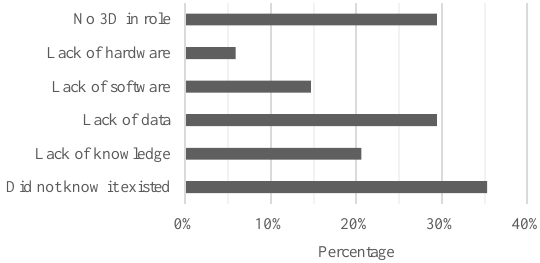
Figure 3. If you are not using 3D data and/or 3D GIS, why not? ( n